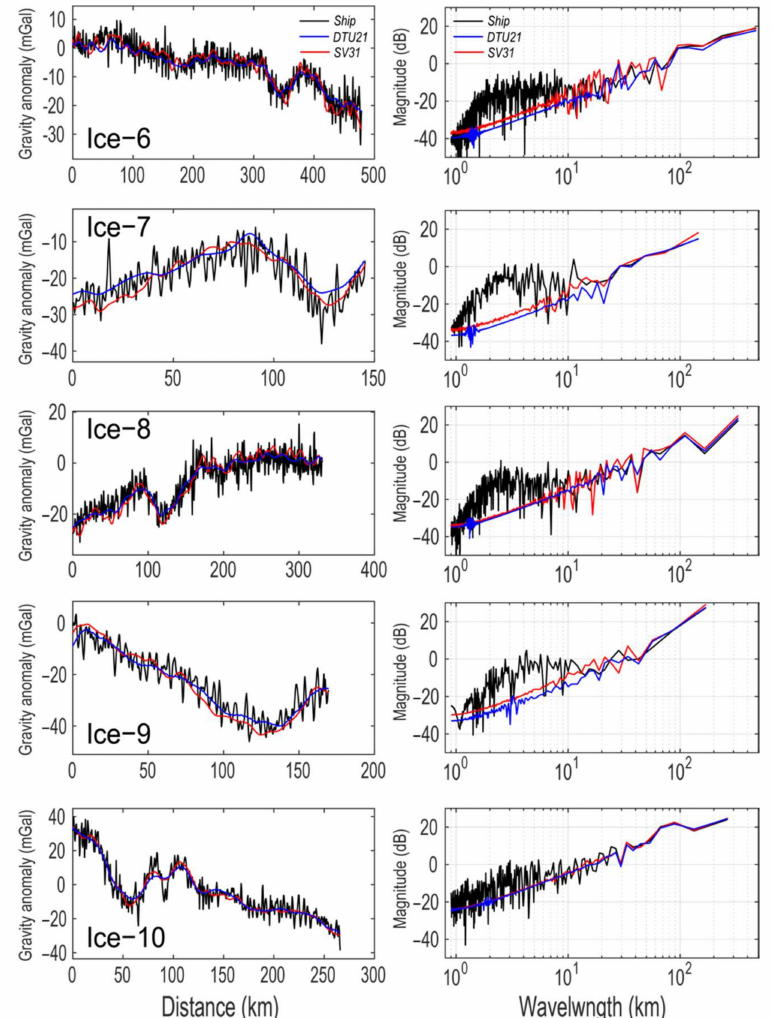
Figure 3. Profiles and power spectra of shipborne and satellite altimetric gravity that were seriously affected by sea ice (solid red lines in Figure 1). The figures in the left column show the free-air gravity of profiles. The figures in the right column show the power spectra of free-air gravity. The black, red, and blue lines indicate the shipborne gravity data, SV31 gravity data, and DTU21 gravity data,